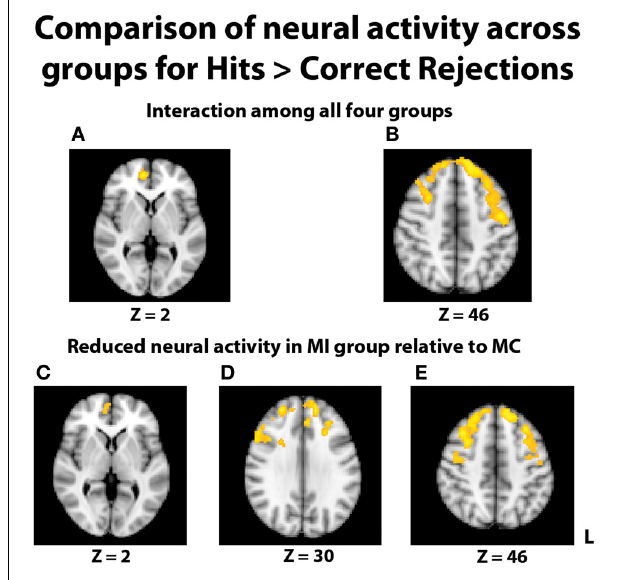
FIGURE 4 | Images displayed depict differential group activity for the contrast of hits > correct rejections. (A,B) Brain regions significant for the interaction between age and TBI history, as measured by the contrast (YI + MC > YC + MI). Areas with significant activity include the right medial PFC, left precentral gyrus, and bilateral superior frontal gyri. (C–E) Reductions in neural activity for the MI group relative to the MC group in multiple areas of the PFC. Coordinates are in MNI space; images are in radiological orientation (L =